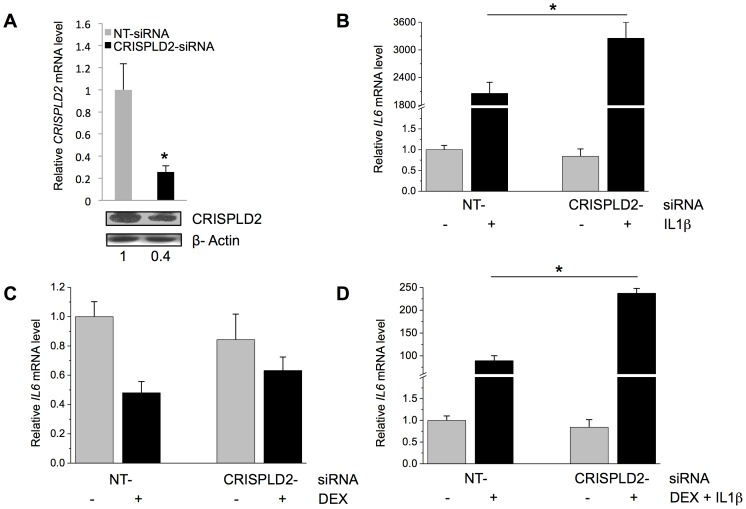

CRISPLD2 regulates the response to inflammatory cytokines.
A) Effect of CRISPLD2-specific siRNA on CRISPLD2 mRNA and protein levels. ASM cells were transfected with CRISPLD2-specific siRNA or non-targeting (NT) siRNA, and 72 h later, CRISPLD2 mRNA and protein levels were determined by qRT-PCR (levels normalized to those in control cells transfected with NT siRNA) and immuno-blotting, respectively. The effect of CRISPLD2 knockdown on IL1β-induced cytokine expression was assessed by transfecting ASM cells with CRISPLD2-specific or NT siRNA, and 72 h later, treating cells for 24 h with B) 5 ng/mL IL1β, C) 100 nM DEX, or D) 5 ng/mL IL1β and 100 nM DEX. IL6 expression was determined by qRT-PCR. Normalized mRNA levels are shown. Experiments were performed in triplicate, and the error bars are SE values for three samples. * P<0.05 (t test).